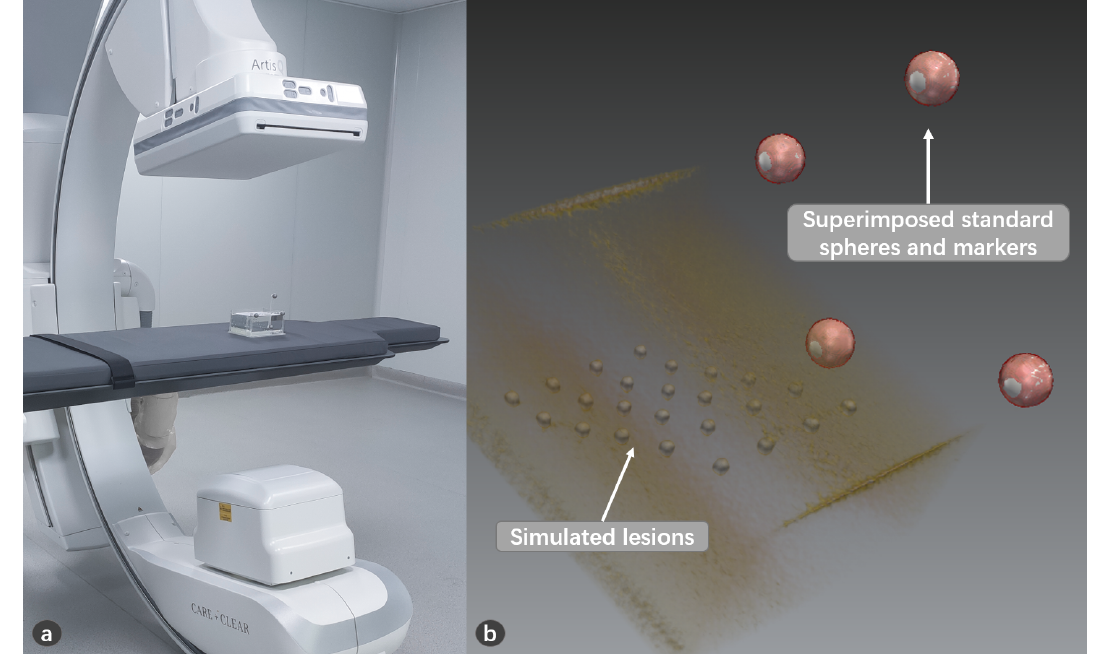
Figure 8. The patient registration. ( a ) CT scan the patient together with sphere markers; ( b ) CT image registered with sphere markers.